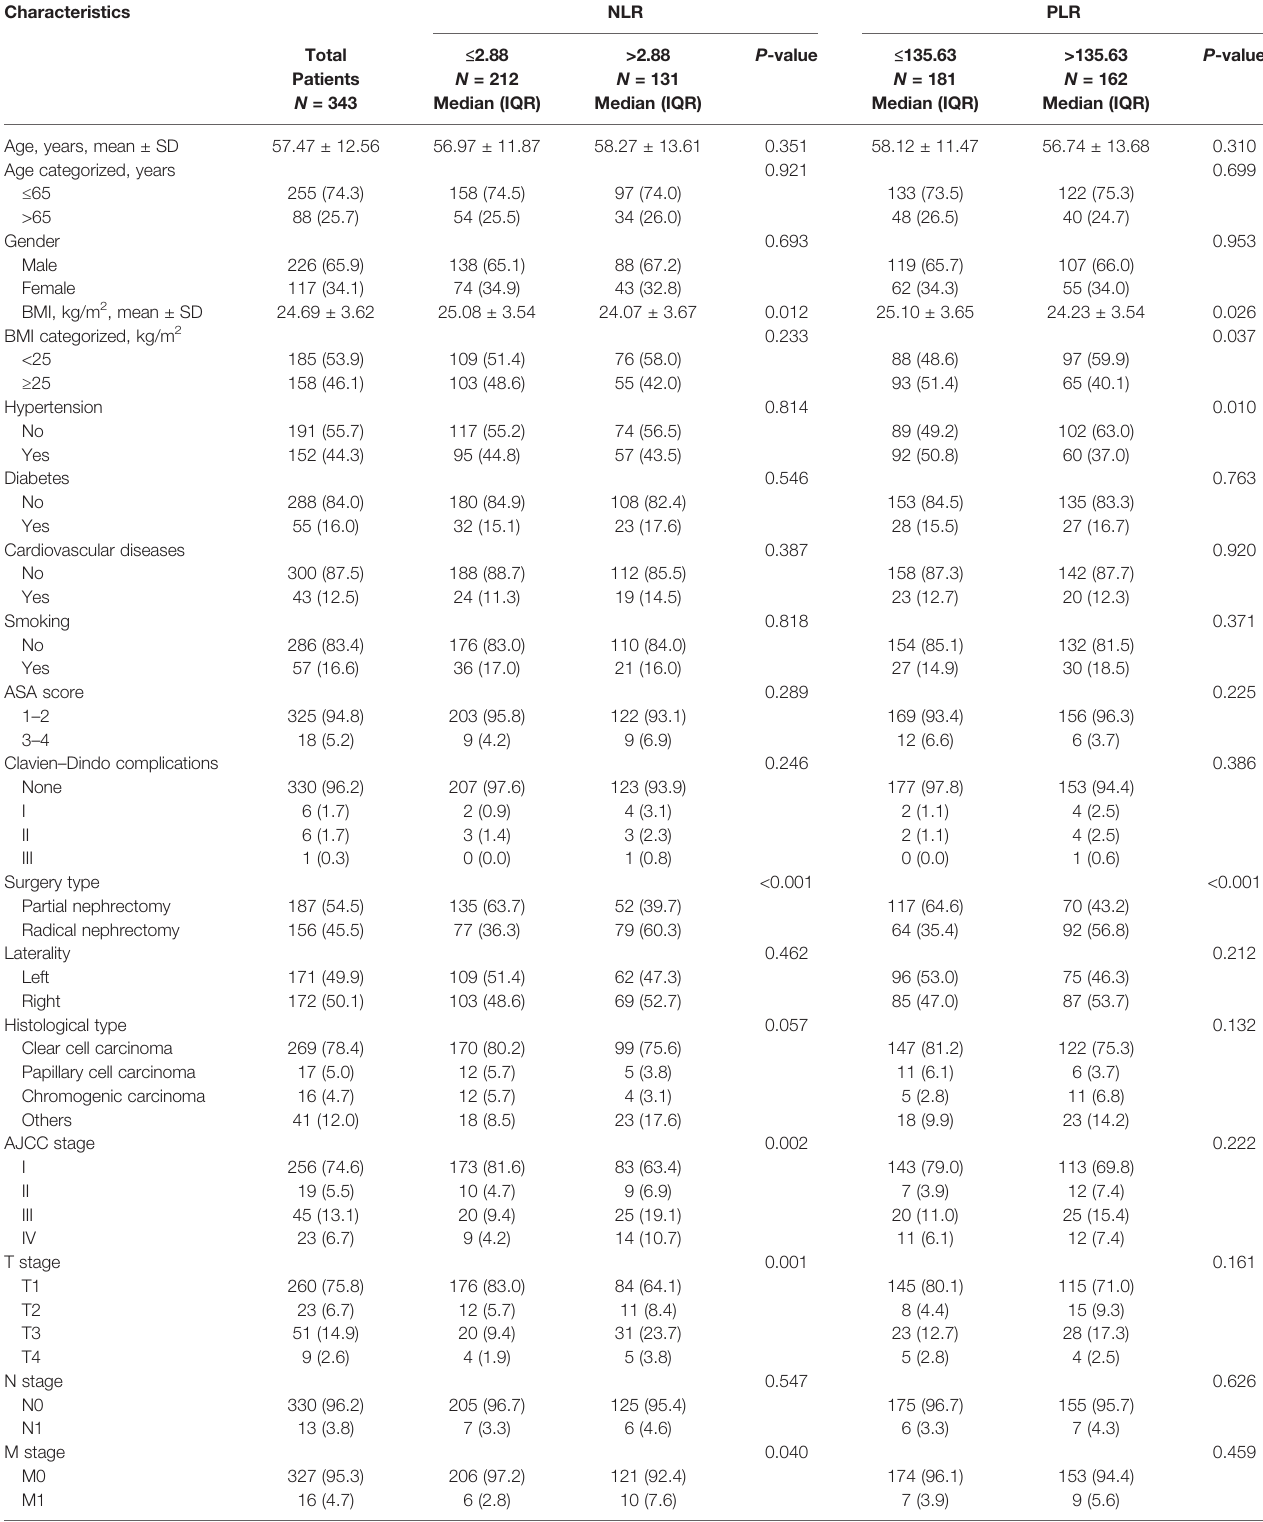
TABLE 1 | Clinical characteristics of the patients according to NLR and PLR.